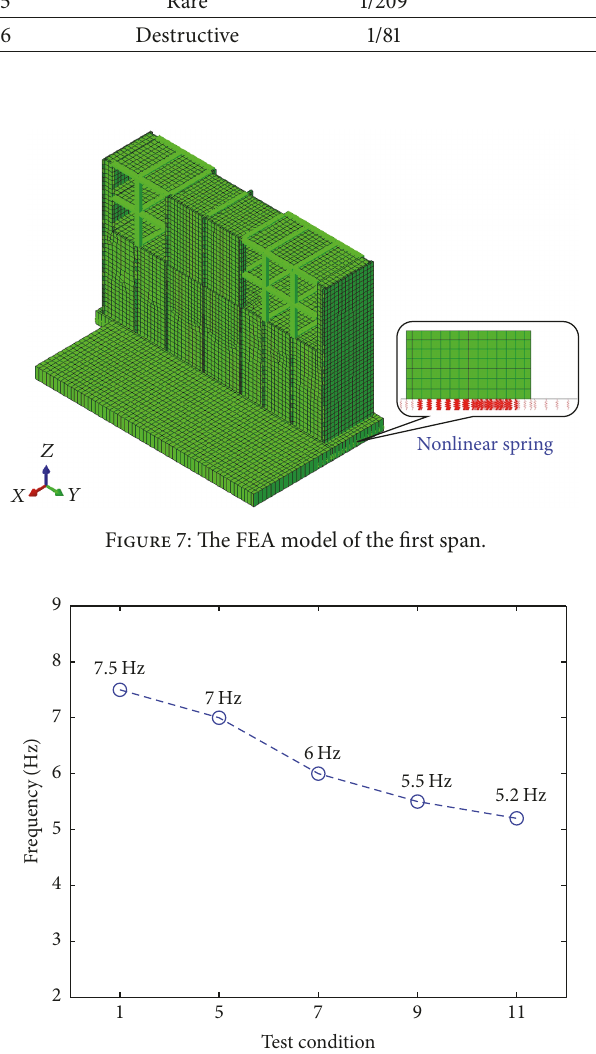
Figure 8: Results of natural frequency